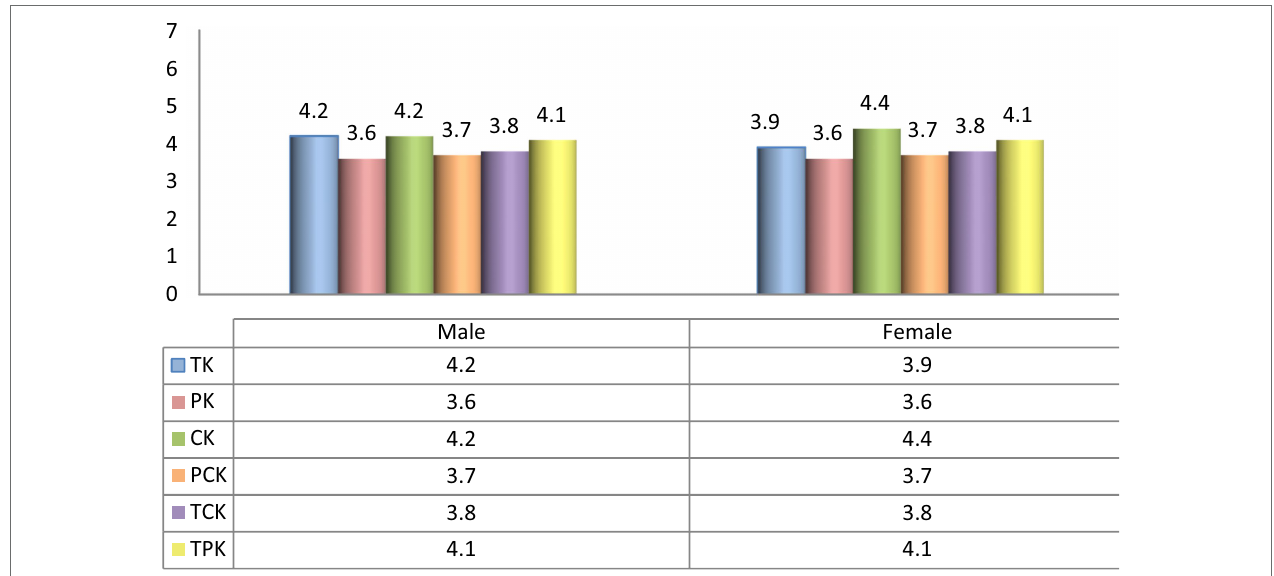
FIGURE 3 | Distribution of components of TPACK by gender.